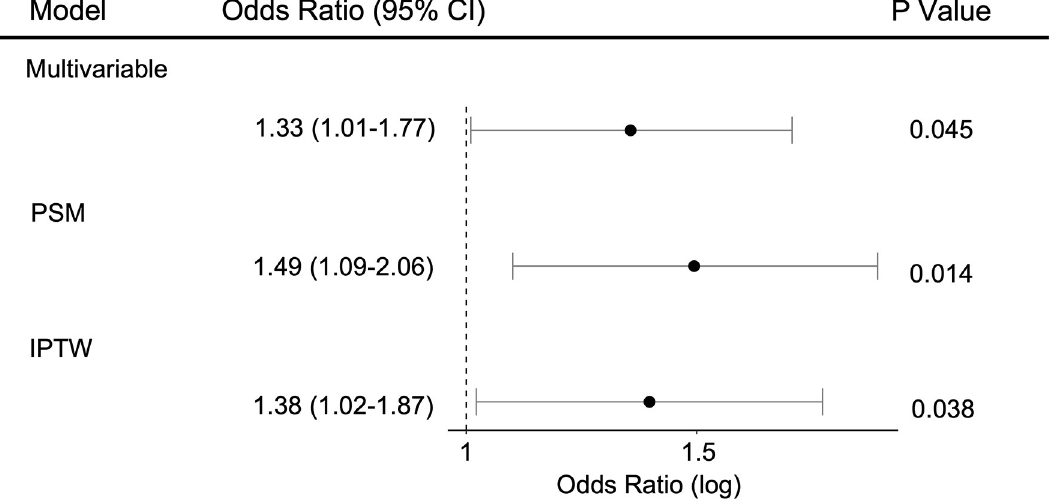
Fig 4. Primary outcome analysis with three different models. Warfarin sensitivity was significantly associated with increased in- hospital mortality. PSM, propensity score matching; IPTW, inverse probability of treatment